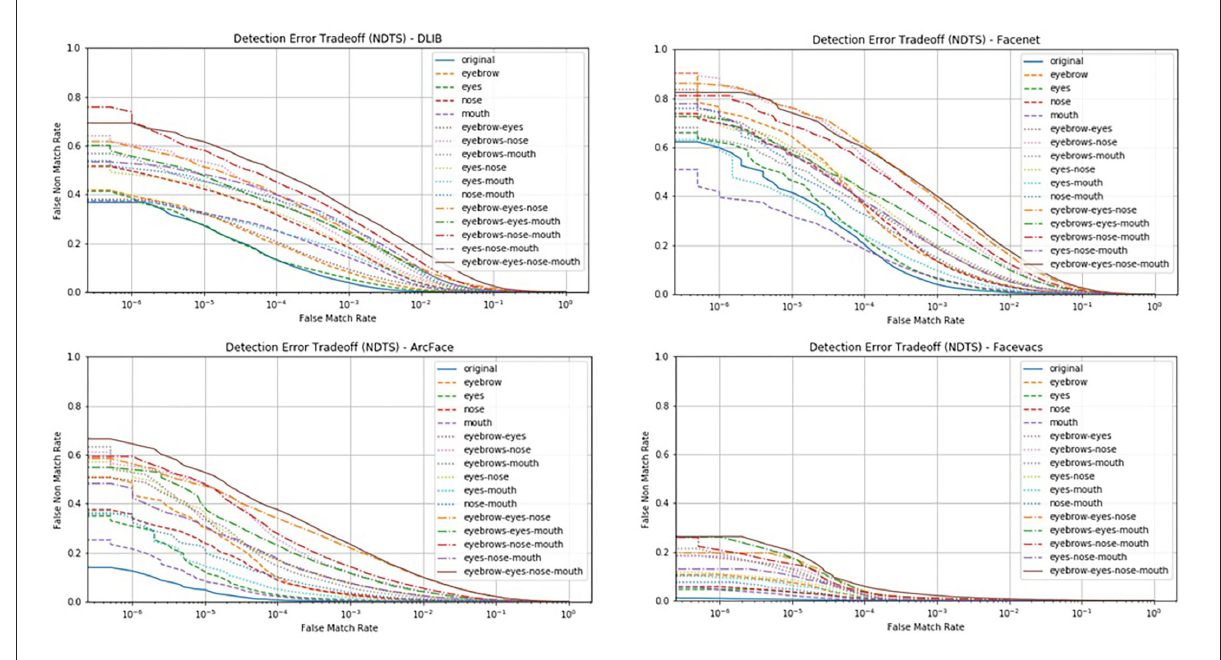
FIGURE9 Face part analysis of NDTS experiment using DET.